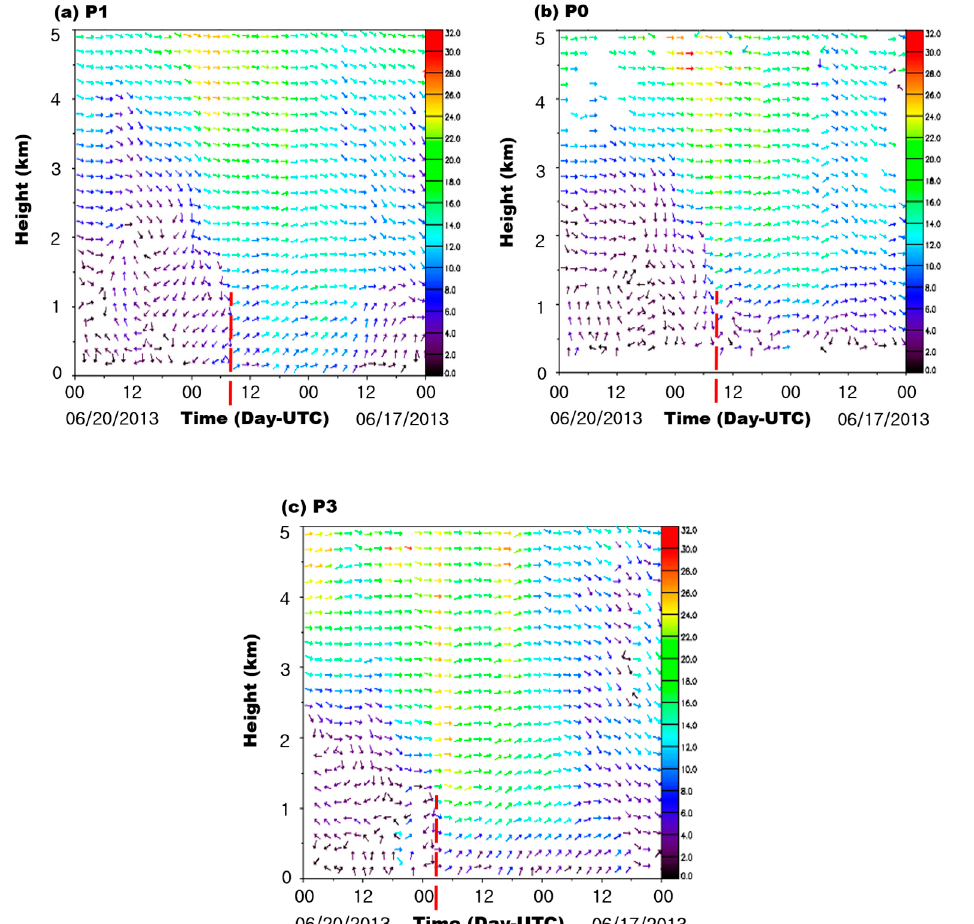
Figure 4. Wind vectors observed by wind profilers ( a ) at P1, ( b ) at P0, and ( c ) at P3 with an inverse time axis. Red dashed lines indicate the arrival of front at each site.